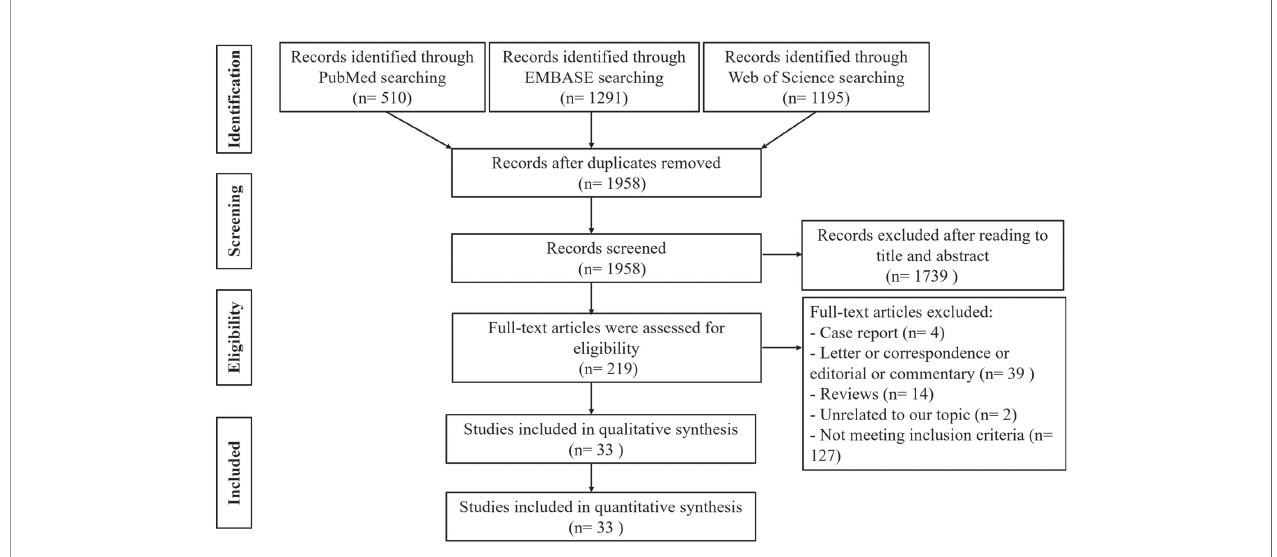
FIGURE 1 | The process of the literature search and